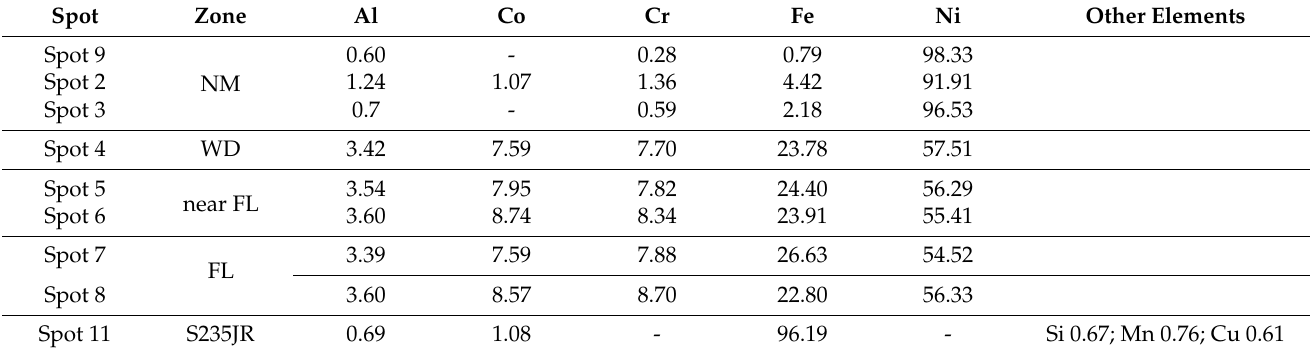
Table 3. Chemical composition, wt.%, in the measurement points shown in Figure 8. Figure 7. Transition from weld metal to S235 JR: ( a ) fusion line between WD and unalloyed steel; ( b ) distribution of the main chemical elements in this area.